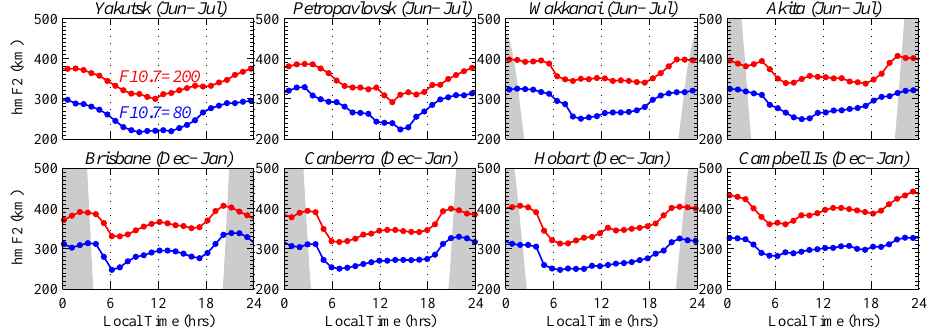
Figure 5. Local time variations of mid-latitude hm F2 at the two solar activity levels in local summer; hm F2 data are derived from the hm F2– F 10 . 7 linear fittings. Grey areas denote the altitudinal ranges where sunlight is kept out on local summer solstice